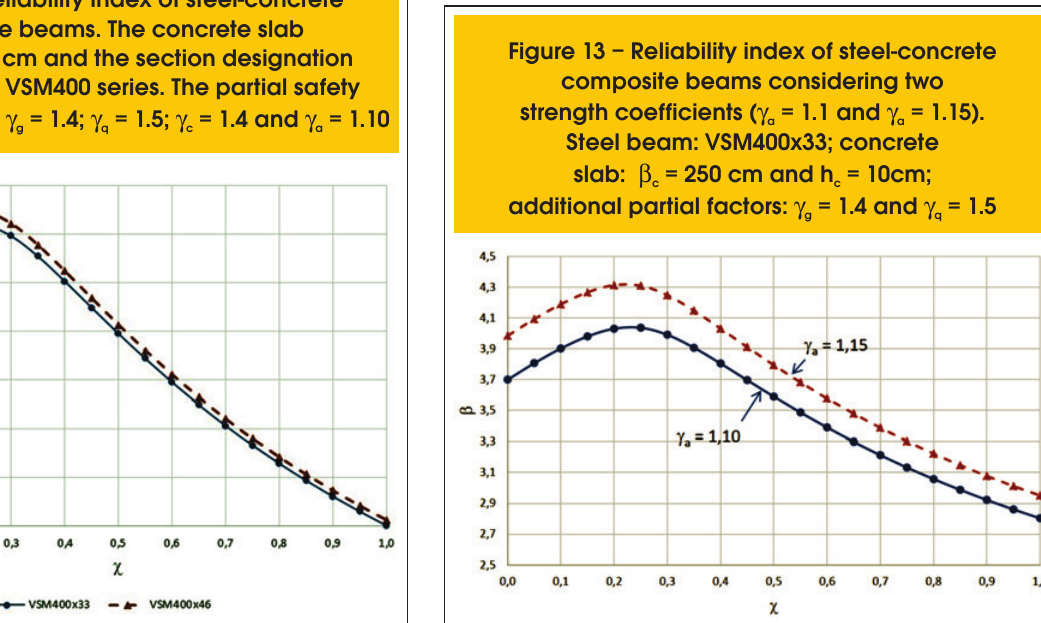
Figure 12 – Reliability index of steel-concrete composite beams. The concrete slab is 250 cm x 10 cm and the section designation belongs to are VSM400 series. The partial safety